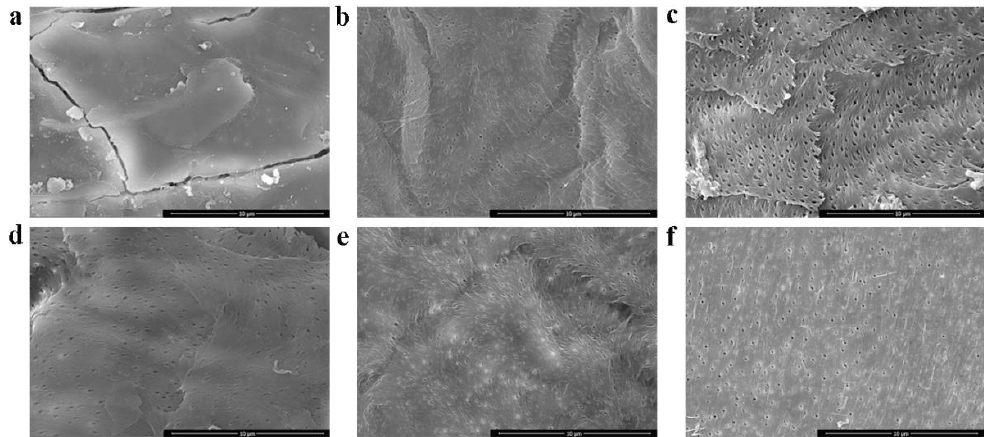
Figure 3. SEM images of ( a ) shrimp shells, ( b ) chitin extracted by the acid/alkali method, ( c ) chitin extracted by betaine HCl-urea, ( d ) chitin extracted by ChCl-urea, ( e ) chitin extracted by ChCl-ethylene glycol, and ( f ) chitin extracted by ChCl-glycerol.